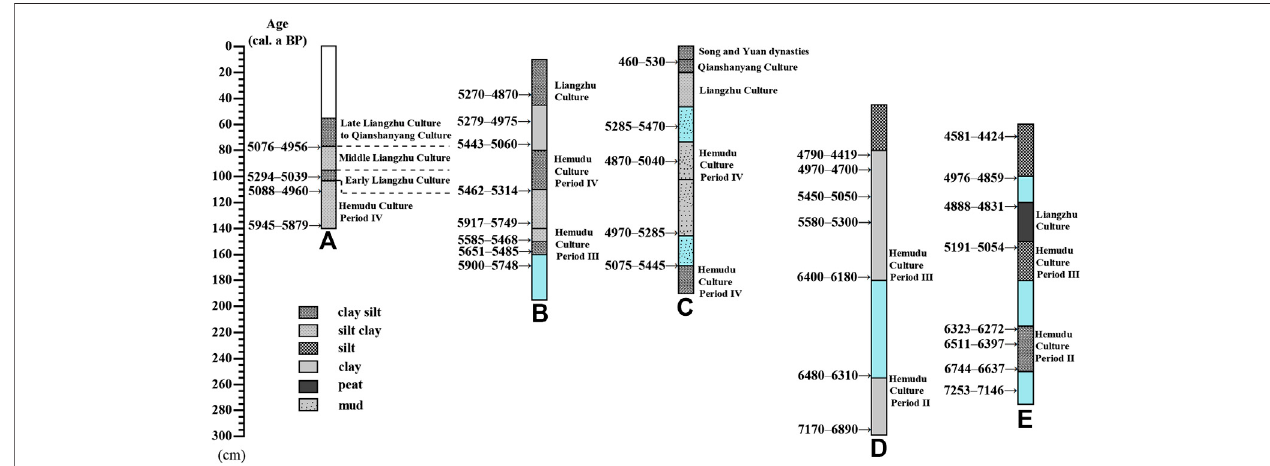
FIGURE 2 | Comparisons of the litho-chronostratigraphy and archaeological layers in this study area: (A) the Hejia Site (this study), (B) the pro fi le T0602W of the Xiawangdu Site (He et al., 2020a), (C) the pro fi le T0103W of the Xiawangdu Site (Huang et al., 2021), (D) the Tianluoshan Site (Zheng, et al., 2012), and (E) the Yushan Site(Heetal.,2018).Themarineintrusionorextremeeventisdisplayedinblueshadowaccordingtothereferences(Zheng,etal.,2012;Heetal.,2018;Heetal.,2020a; Huang et al., 2021).